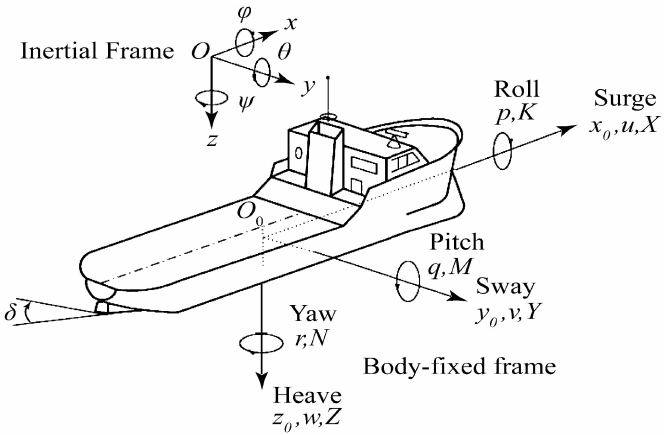
Figure 1. Ship motion